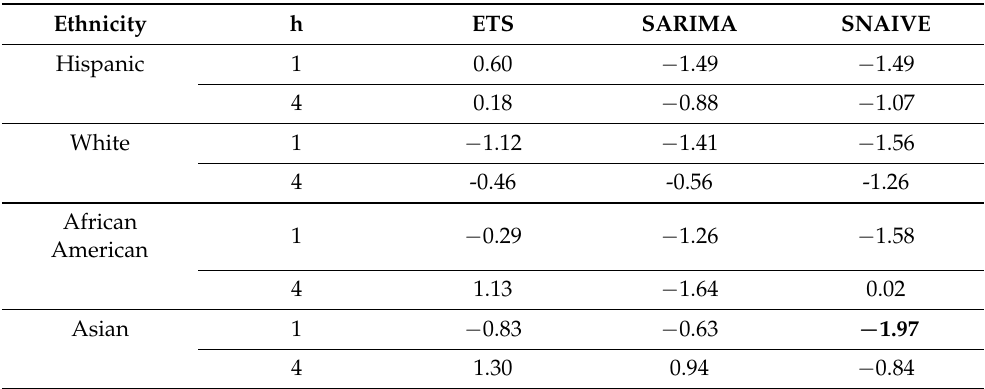
Table 8. Results of the modified Diebold–Mariano test comparing ITSA to ETS, SARIMA without intervention, and SNAIVE by ethnicity. Ethnicity h ETS SARIMA SNAIVE Hispanic 1 0.60 − 1.49 − 1.49 4 0.18 − 0.88 − 1.07 White 1 − 1.12 − 1.41 − 1.56 4 -0.46 -0.56 -1.26 African 1 − 0.29 − 1.26 − 1.58 American 4 1.13 − 1.64 0.02 Asian 1 − 0.83 − 0.63 − 1.97 4 1.30 0.94 −